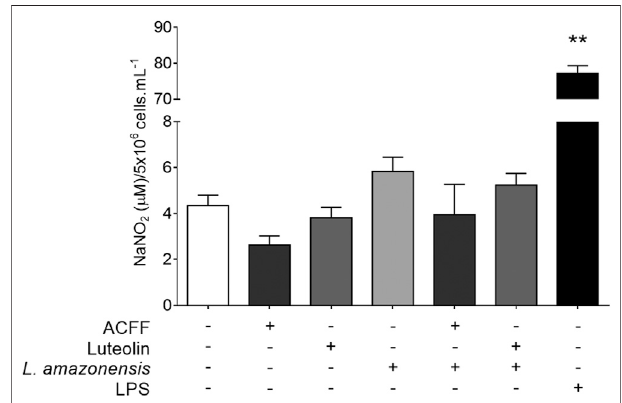
FIGURE4| Nitritequanti fi cation inthesupernatantofBALB/cperitoneal macrophages treated with Arrabidaea chica fl avone-rich fraction (ACFF) (2.5 μ g/mL) or luteolin (25 μ g/mL), stimulated or not with Leishmania amazonensis .Datarepresentsmean ± standard deviation of experiment realized in sextuplicate; ** p < 0.01 when compared with untreated and unstimulated macrophages by Mann-Whitney test.